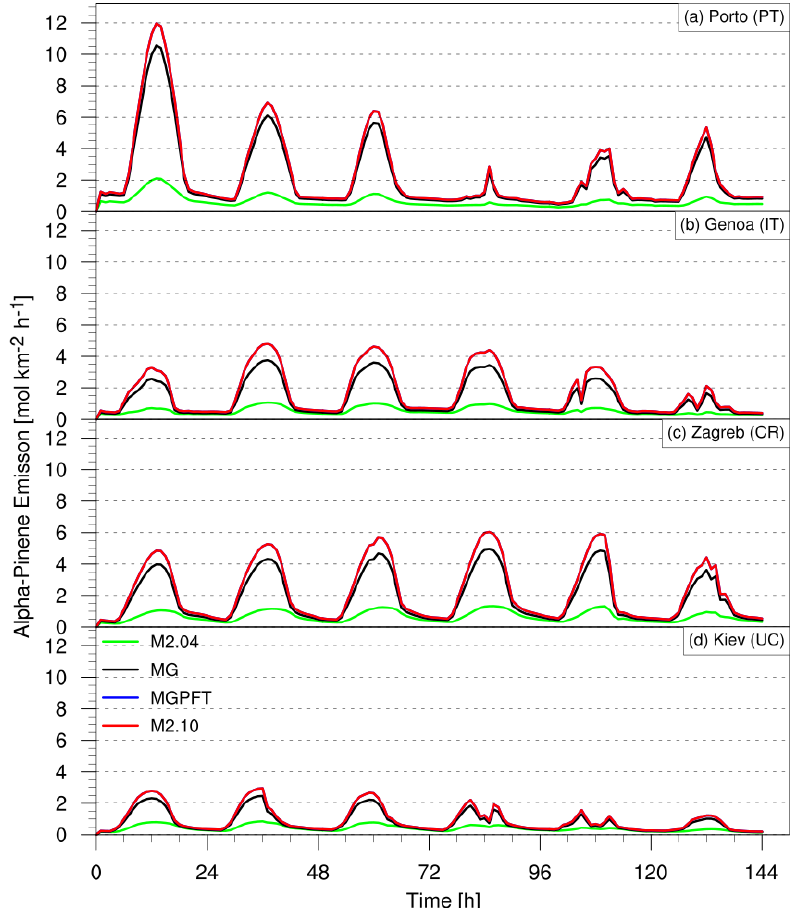
Figure 9. Time series of α -pinene emissions (molkm − 2 h − 1 ) for different MEGAN algorithm configurations evaluated in four cities in Europe: (a) Porto, Portugal; (b) Genoa, Italy; (c) Zagreb, Croatia; (d) Kyiv, Ukraine. The time period considered is from 10 August 2015 at 00:00UTC to 16 August 2015 at 00:00UTC. The green lines represent the control simulation (M2.04), the black lines indicate the activity factor ( γ i ) updates (MG), the blue lines are representative of the PFT emission factor updates (MGPFT), and the red lines show the isoprene emission factor as the emission factor of all the other compound classes